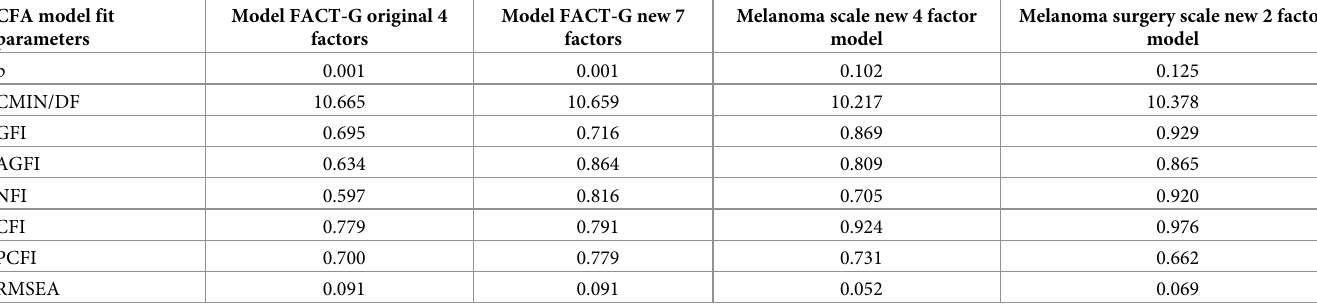
Table 5. Results of the confirmatory factor analysis according to domains and subscales of the FACT-M